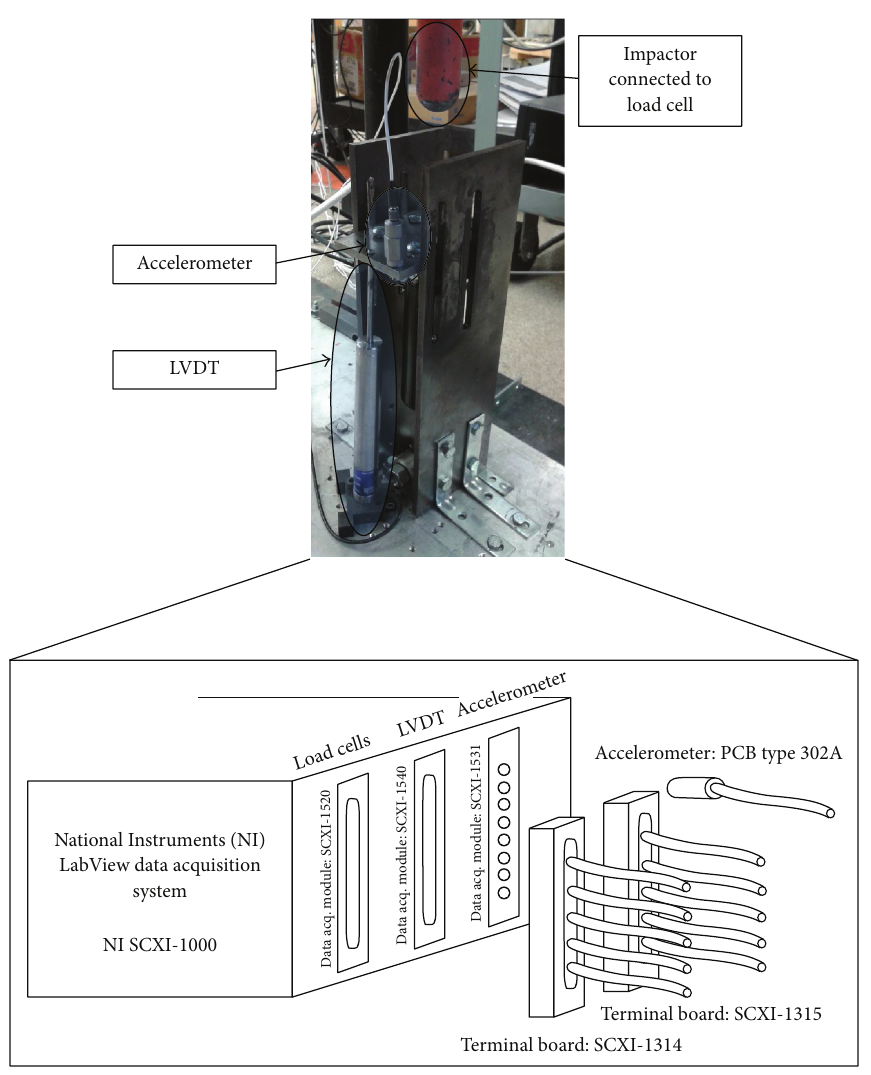
Figure 7: Configuration of the data acquisition